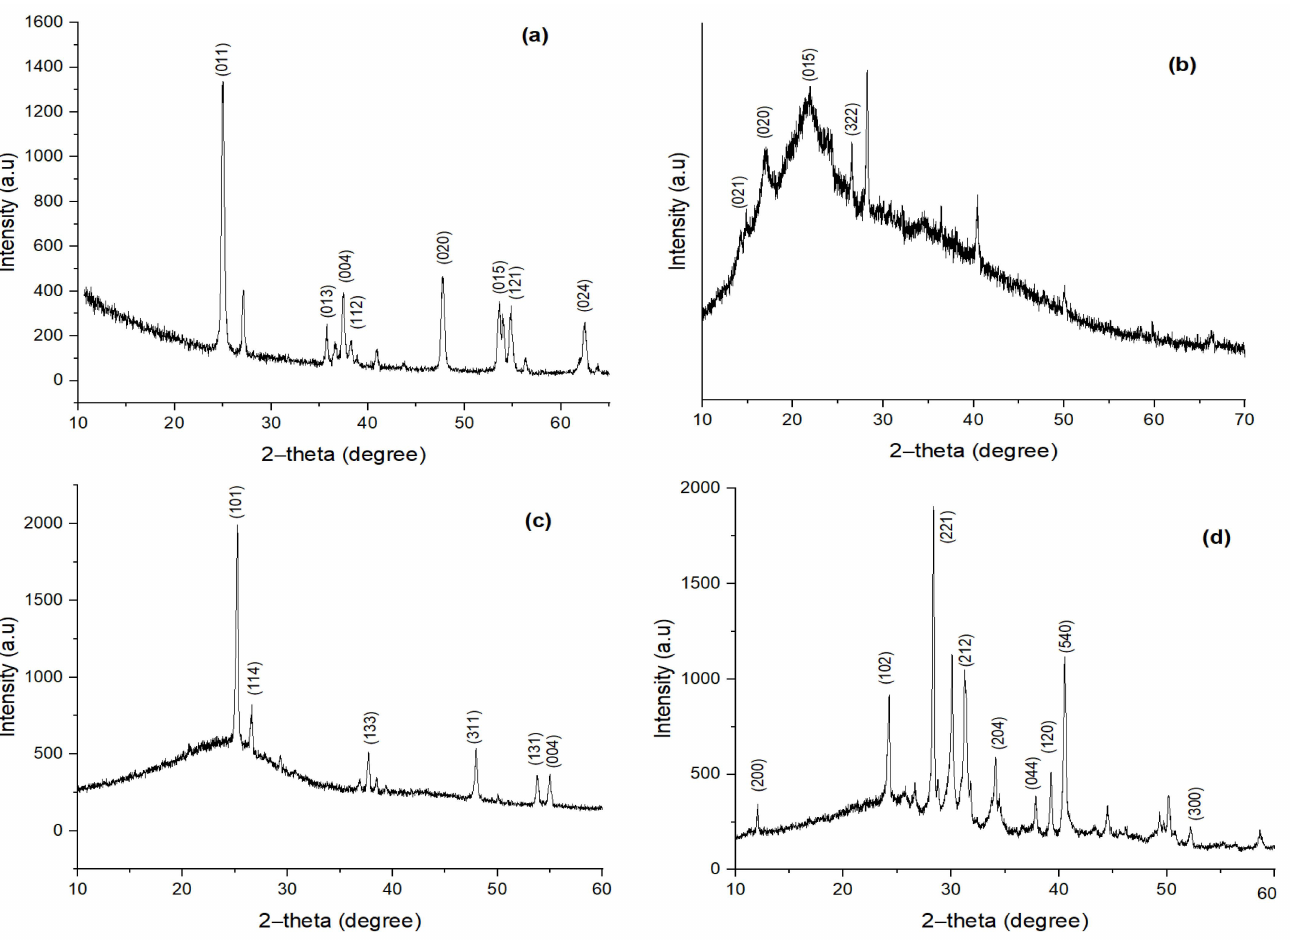
Figure 5. XRD pattern of ( a ) TiO 2 NP; ( b ) biomass; ( c ) biochar; and ( d ) TiO 2